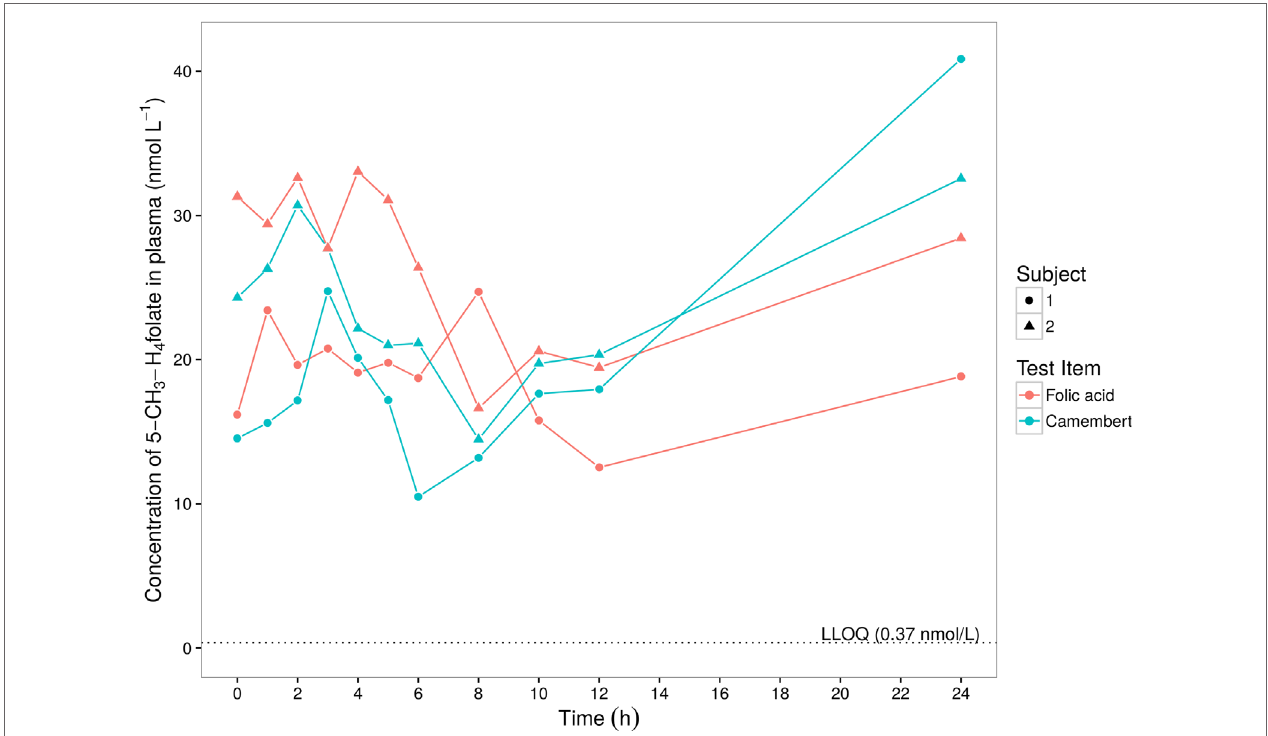
FigUre 1 | 5-Methyltetrahydrofolate levels in plasma of two volunteers after intake of folic acid solution or camembert cheese